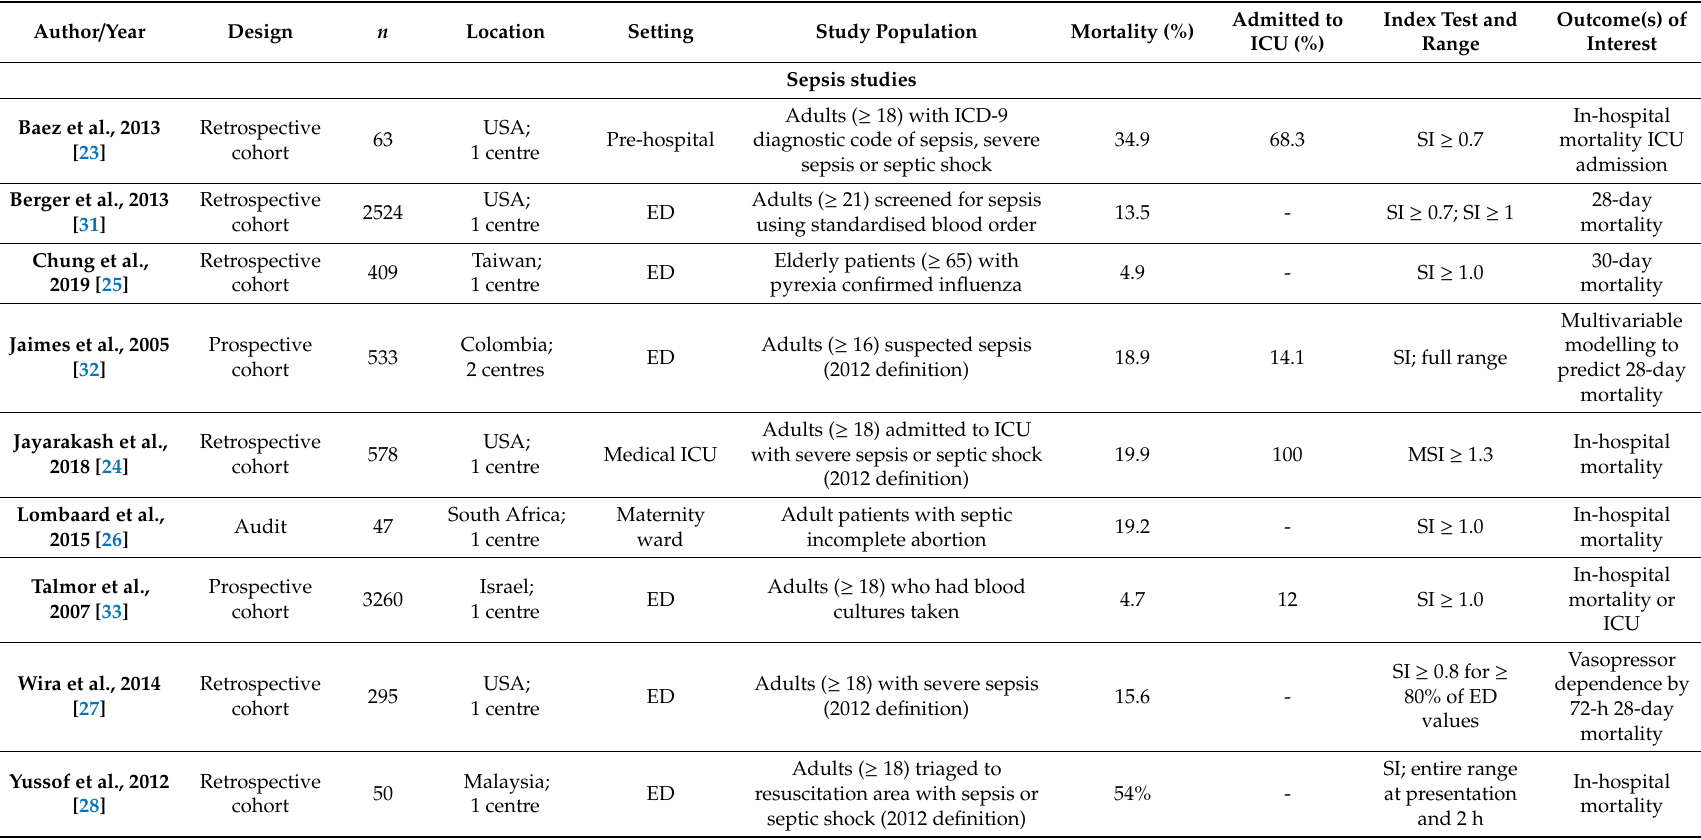
Table 1. Characteristic of included